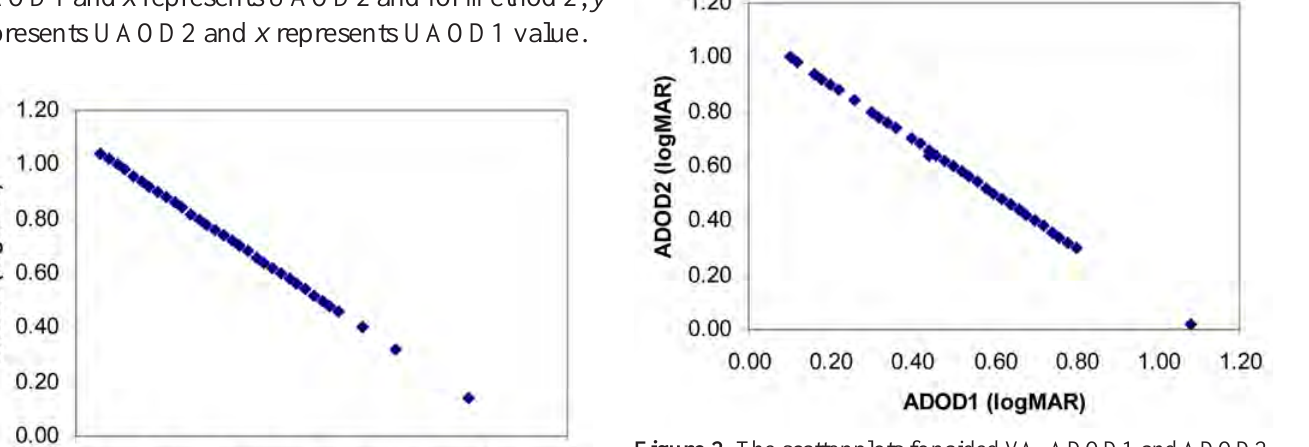
Figure 2. The scatter plots for aided VA, ADOD1 and ADOD2. The plot shows a perfect inverse relationship between methods 1 and 2. Again, most of the coordinates are the same; hence many points lie on each other.